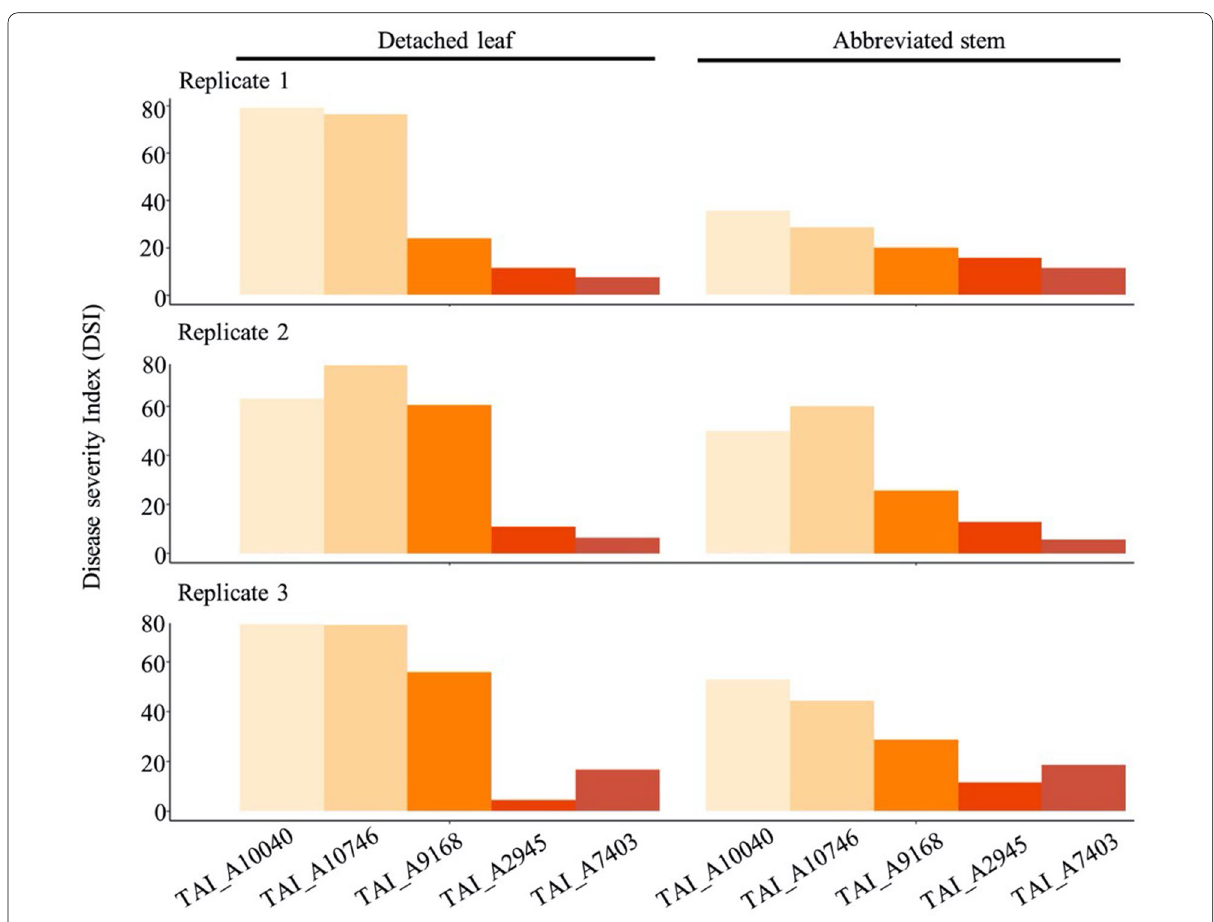
Fig. 4 The comparison of DSI among replicates based on organs